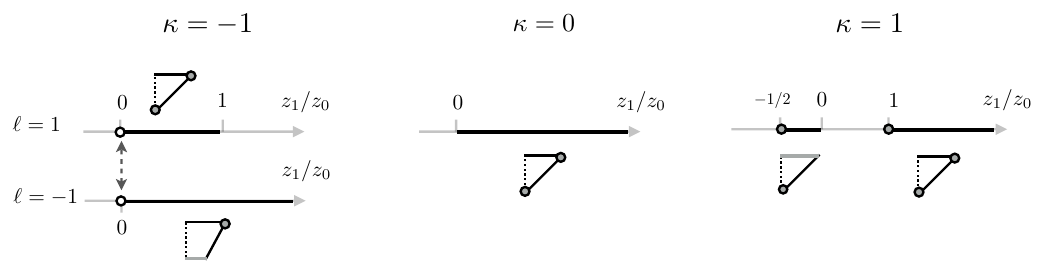
Figure 4 . A summary of the various solutions we found for (cid:20) = 0 ; (cid:12)gures 1, 2 and 3. The grey dot for (cid:20) = 1 is the solution discussed in appendix C. The white dots for (cid:20) = 1 both represent the punctureless solution of [1], whose six-dimensional origin we discuss (cid:0) in section